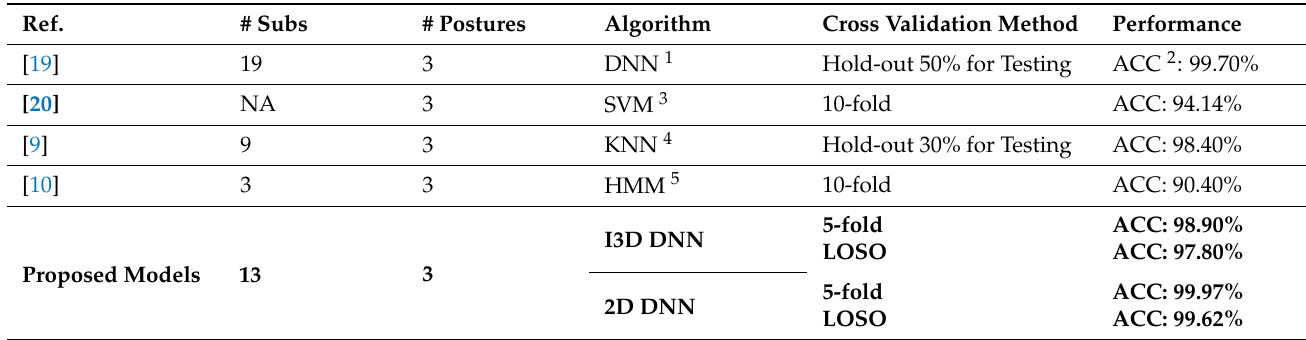
Table 2. A comparison between previous literature on classification of three in-bed postures: supine, right side, and left